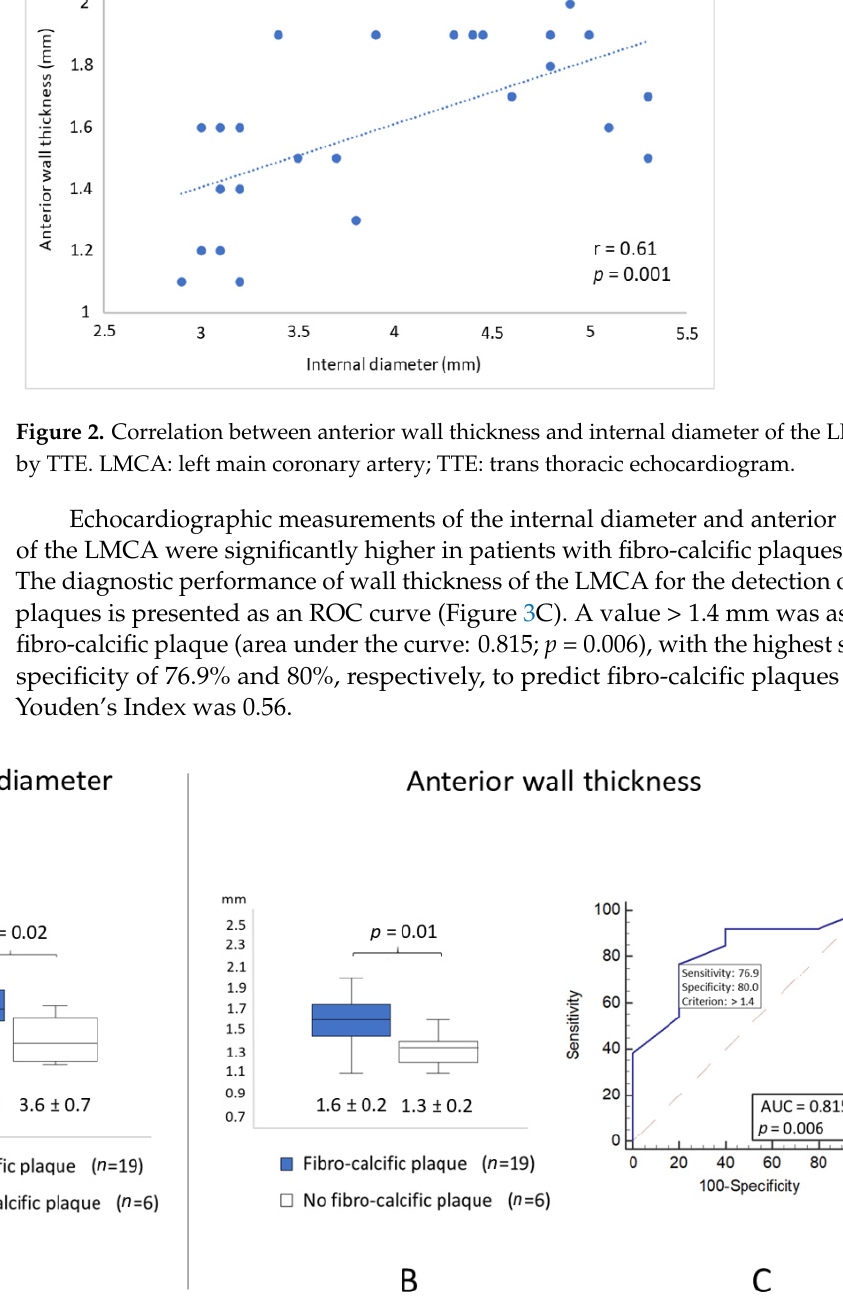
Figure 3. ( A ) internal diameter of the LMCA measured by TTE in patients with and without fibro calcific plaques (4.6 ± 0.9 mm vs. 3.6 ± 0.7 mm, respectively); ( B ) anterior wall thickness of the LMCA measured by TTE in patients with and without fibro calcific plaques (1.6 ± 0.2 mm vs. 1.3 ± 0.2 mm, respectively); ( C ) ROC curves for predicting the presence of fibro ‐ calcific plaques by TTE measure ‐ ment of the anterior wall thickness of LMCA. LMCA: left main coronary artery; OFDI: optical fre ‐ quency domain imaging; ROC: receiver operating characteristic; TTE: transthoracic echography.